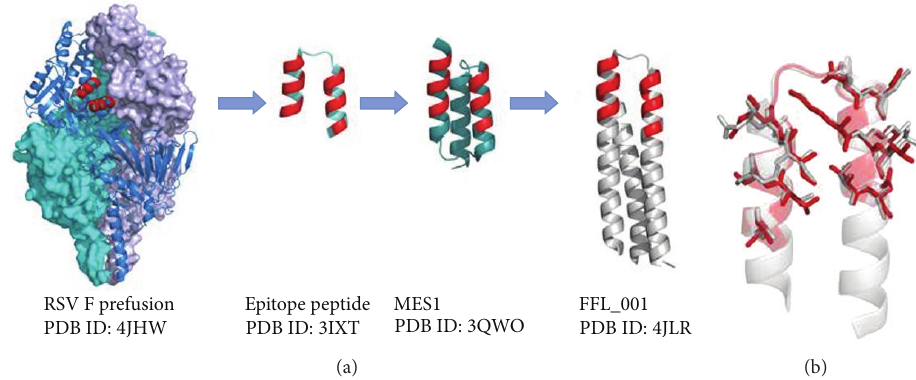
Figure 3: Development of a respiratory syncytial virus (RSV) F scaffold antigen. (a) RSV F Motavizumab epitope is conserved in both pre- and postfusion conformations and a peptide epitope in complex with Motavizumab was shown to have a similar conformation as the epitope in RSV F (PDB ID: 2IXT) [29]. This information was used to design scaffolds presenting the epitope of which the best, MES1 (PDB ID: 3QWO), bound Motavizumab with high affinity but failed to induce protection in mice upon immunization [30] FFL 001 was the first example of a computationally designed scaffold that when used in immunization of macaques induced protection against the virus (PDB ID: 4JLR) [31]. FFL 001 was obtained through a computational de novo epitope scaffold design approach called “Fold From Loops” aimed at faithfully reproducing the epitope with strong immunogenic properties. The epitope on RSV F and the residues responsible for interaction with Motavizumab on the antigen constructs are shown in red. (b) Overlay of the RSV F epitope from prefusion F and the epitope region from FFL 001 illustrates the faithful reproduction of the epitope in FFL 001. Epitope residues important for Motavizumab binding from RSV F are shown in red and the corresponding residues from FFL 001 in